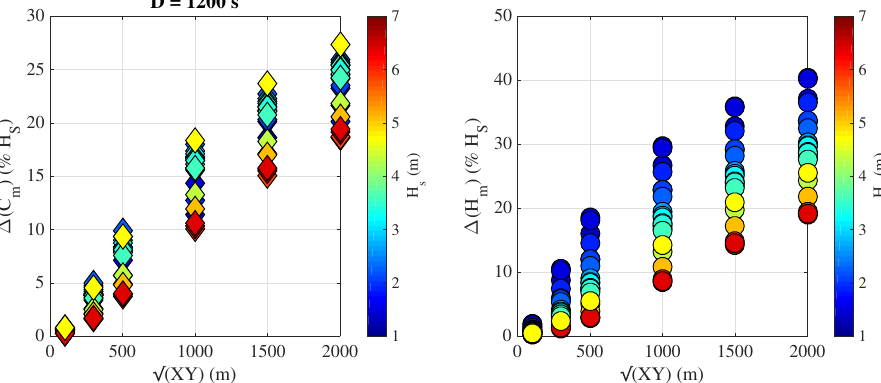
Figure 5. Space-time extreme crest and wave heights. Relative errors ∆ ( C m ) = (E{ C m } − E{ C m } BC ) / H s ( left ), and ∆ ( H m ) = (E{ H m } − E{ H m } BH ) / H s ( right ) as a function of the sea surface area width. Upper limit B C = 1.55 and B H = 2.45. Markers are color-coded with the value of the significant wave height H s of each directional spectrum. Time interval duration D = 1200 s.